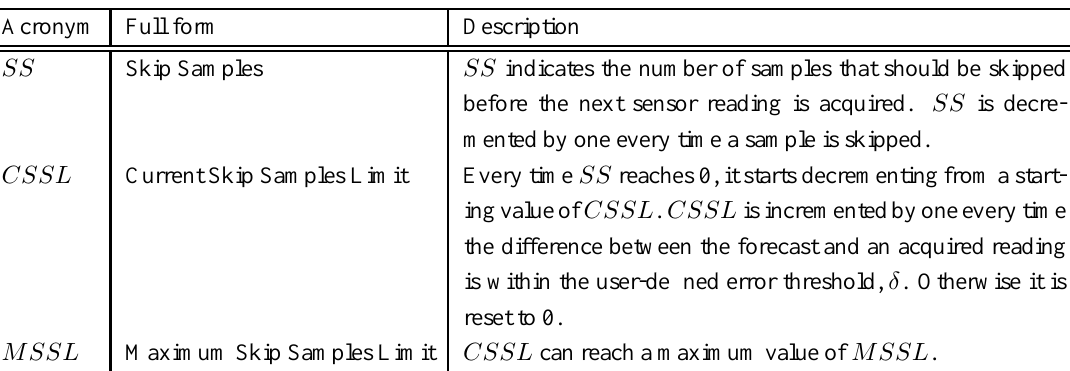
Table 1. Description of acronyms used in Algorithm